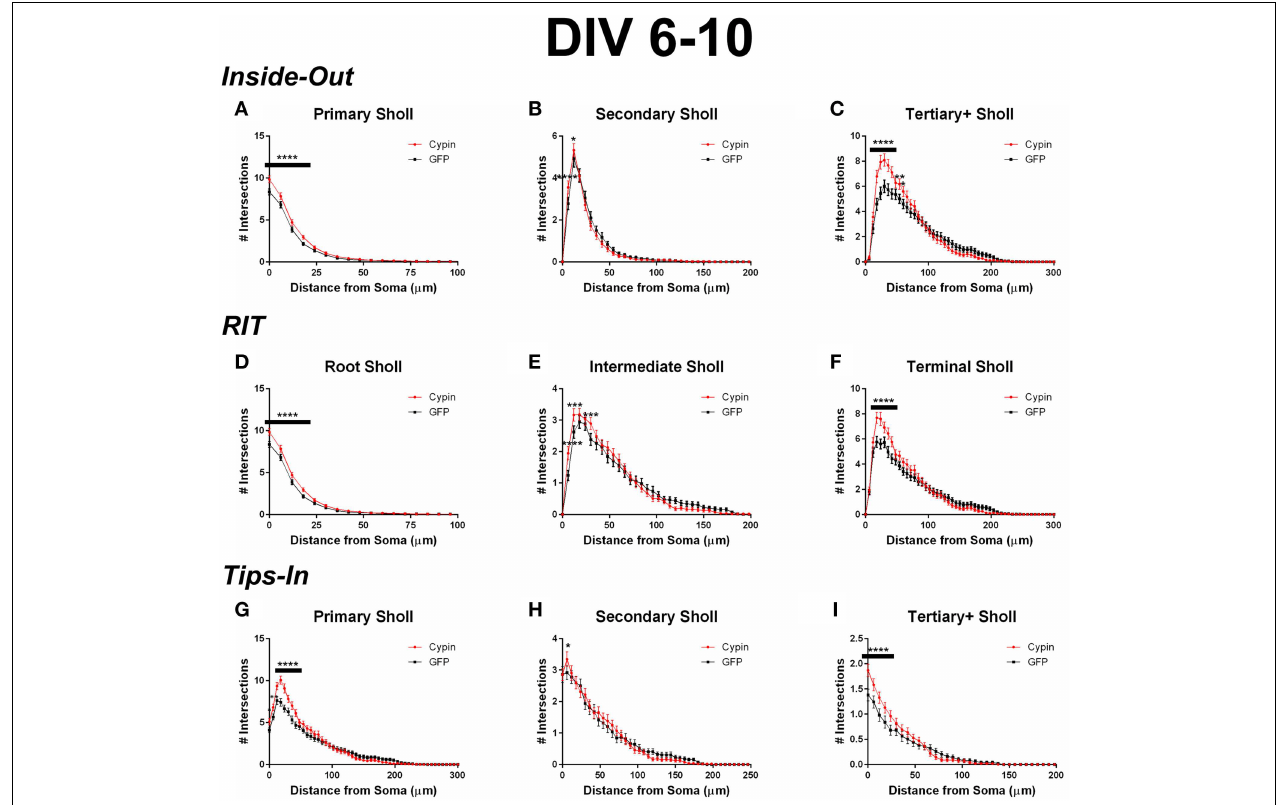
overexpression of cypin significantly increases dendrites at 6 µ m ( **** p < 0 . 0001 ) from the soma and at 12 and 30 µ m from the soma (both *** p < 0 . 001 ). (F) Sholl analysis of terminal dendrites (Terminal Sholl) shows that overexpression of cypin significantly increases dendrites at 18–42 µ m from the soma ( **** p < 0 . 0001 ). (G–I) Sholl analysis using Tips-In labeling method. (G) Sholl analysis of